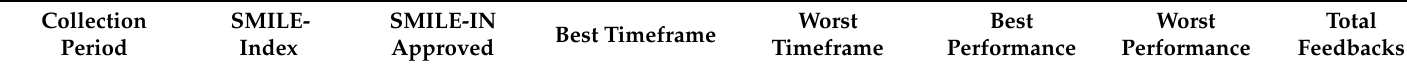
Table 1. Overall survey